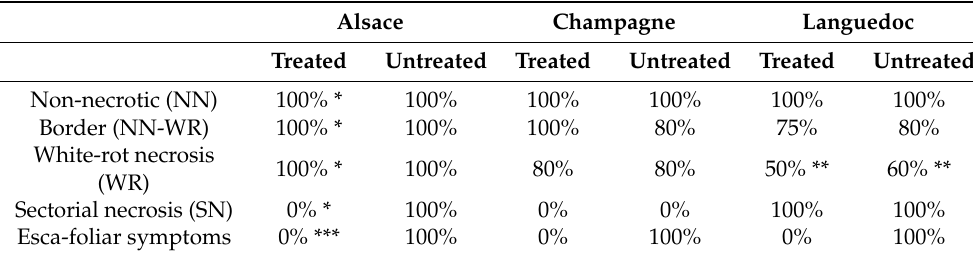
Table 1. Woody necroses and disease status of grapevines sampled in September 2014. *, % of grapevines displaying each type of necrotic woody tissues **, white-rot necrotic tissue was not in sufficient quantities to enable DNA to be extracted. ***, % of grapevines displaying typical esca-foliar